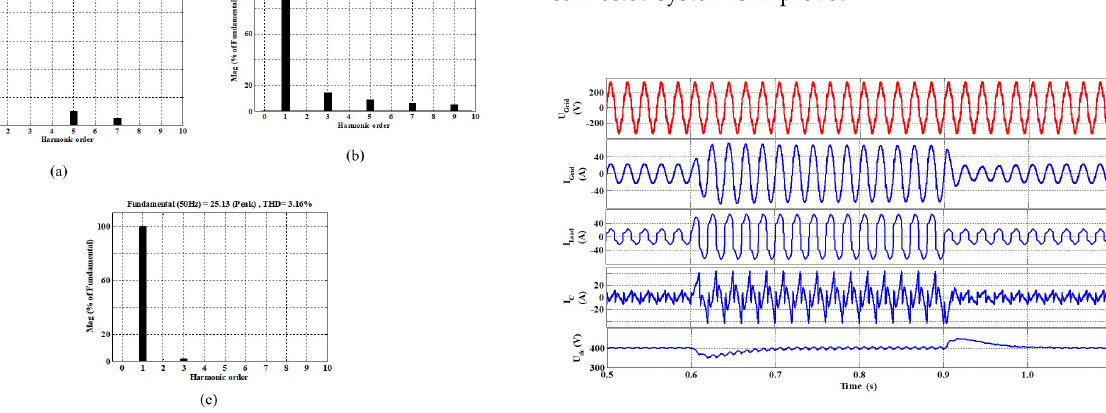
Fig. 8. Dynamic performance of proposed HTWF based Fig. 7. Total harmonic distortion Analysis (a) Grid voltage control technique for PV grid connected System. distortion (b) Grid current THD before compensation (c) after compensation .